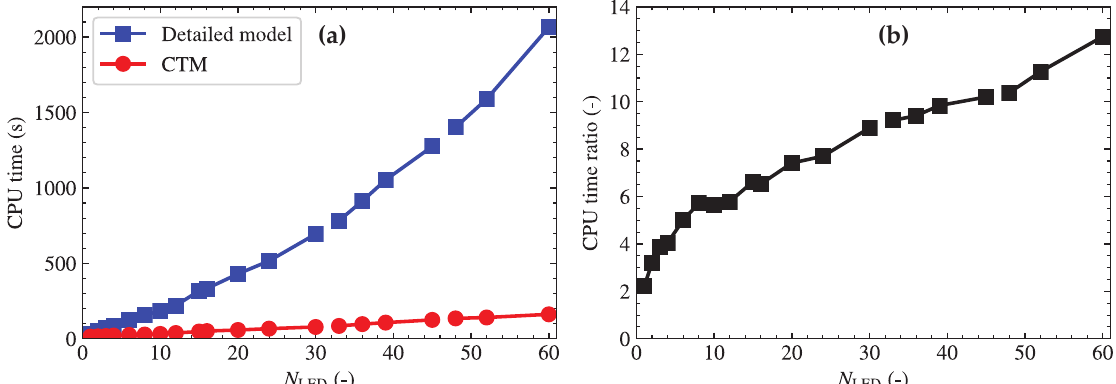
Figure 10. Time required to solve the LED module-level model: ( a ) comparison of CPU time between the LED detailed model and the LED CTM, and ( b ) the ratio in CPU time between the LED detailed model and the LED CTM.